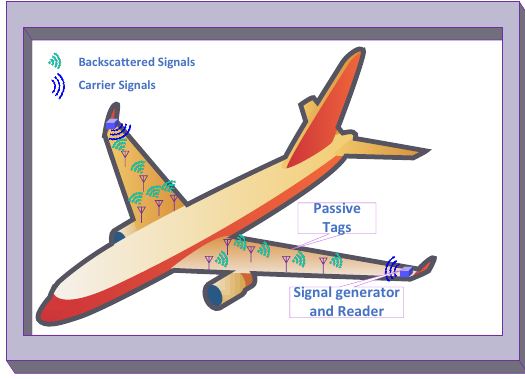
Figure 47. Vehicle health monitoring using BackCom.